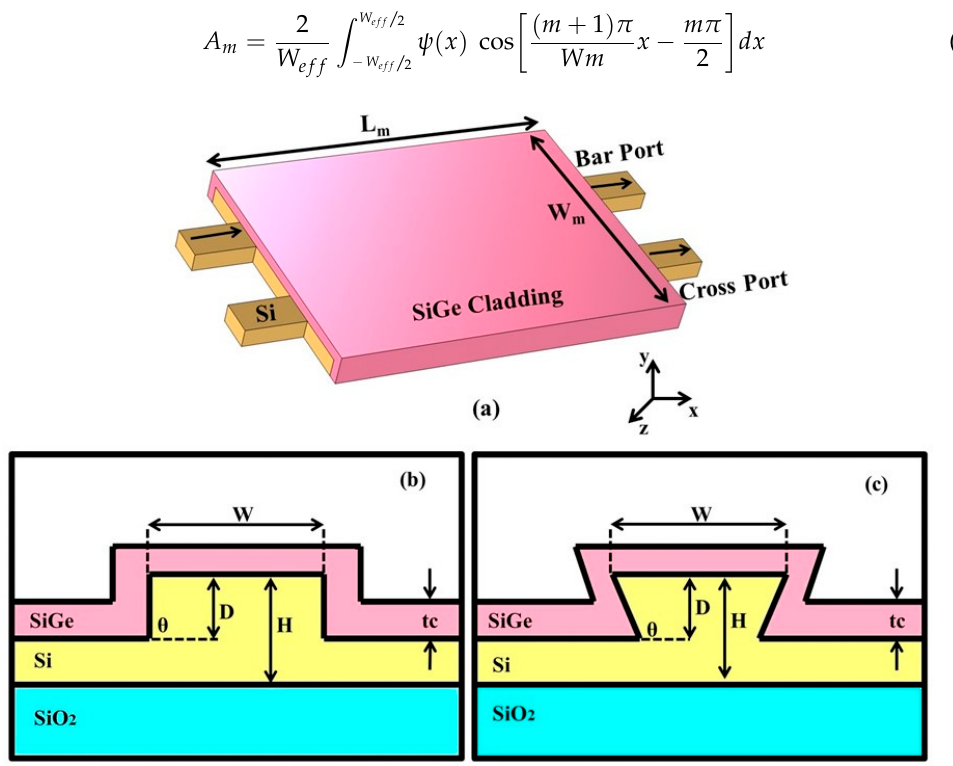
Figure 1. Schematic diagram of ( a ) 2 × 2 MMI coupler with SiGe as b ) ( b ) rectangular and ( c ) trapezoidal waveguide rectangular and ( c ) trapezoidal waveguide cross-section.